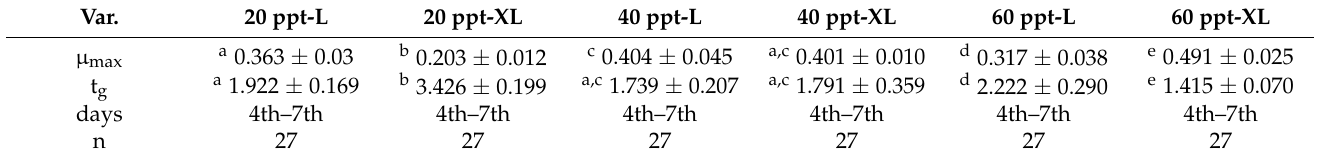
Table 1. Records of growth parameters of the cultures of Phormidium sp. in the conditions examined: L = light of 2000 lux, XL = light of 8000 lux, µ max = specific growth rate between days 4 and 7 of the culture period, t g = days for doubling of the algal population. Values are means ± S.D. of 27 measurements. Same or different superscripts (a, b, c, d, e) denote non-significant or significant differences, respectively, at a 0.05 level of confidence, examined by a pair-wise Tukey’s test.